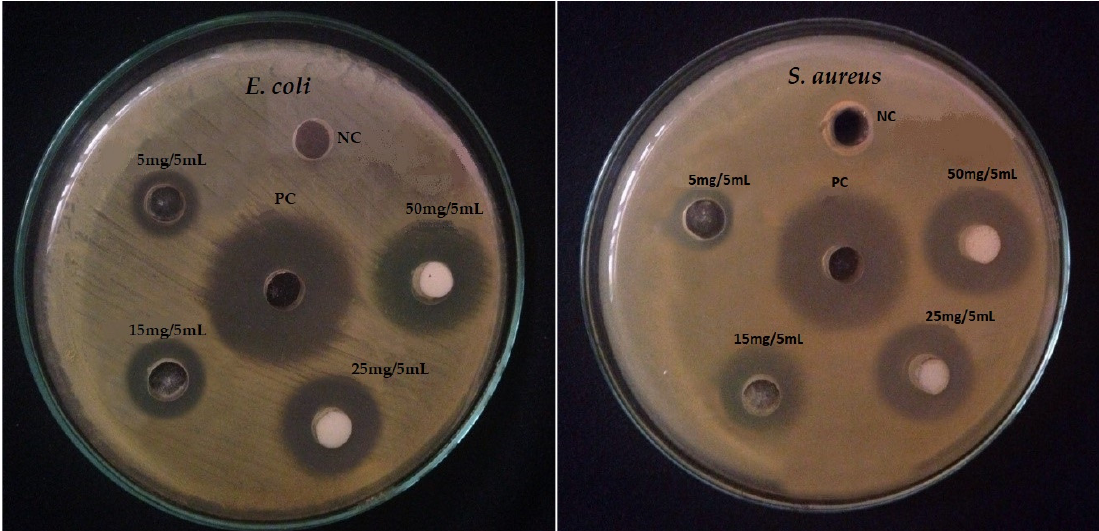
Figure 8. Pictorial representation of bactericidal activity of Ag-CuO NC against E. coli and S. aureus .